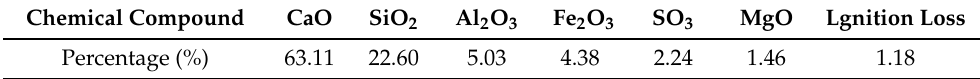
Table 1. Chemical composition of P.O42.5 grade ordinary Portland cement.